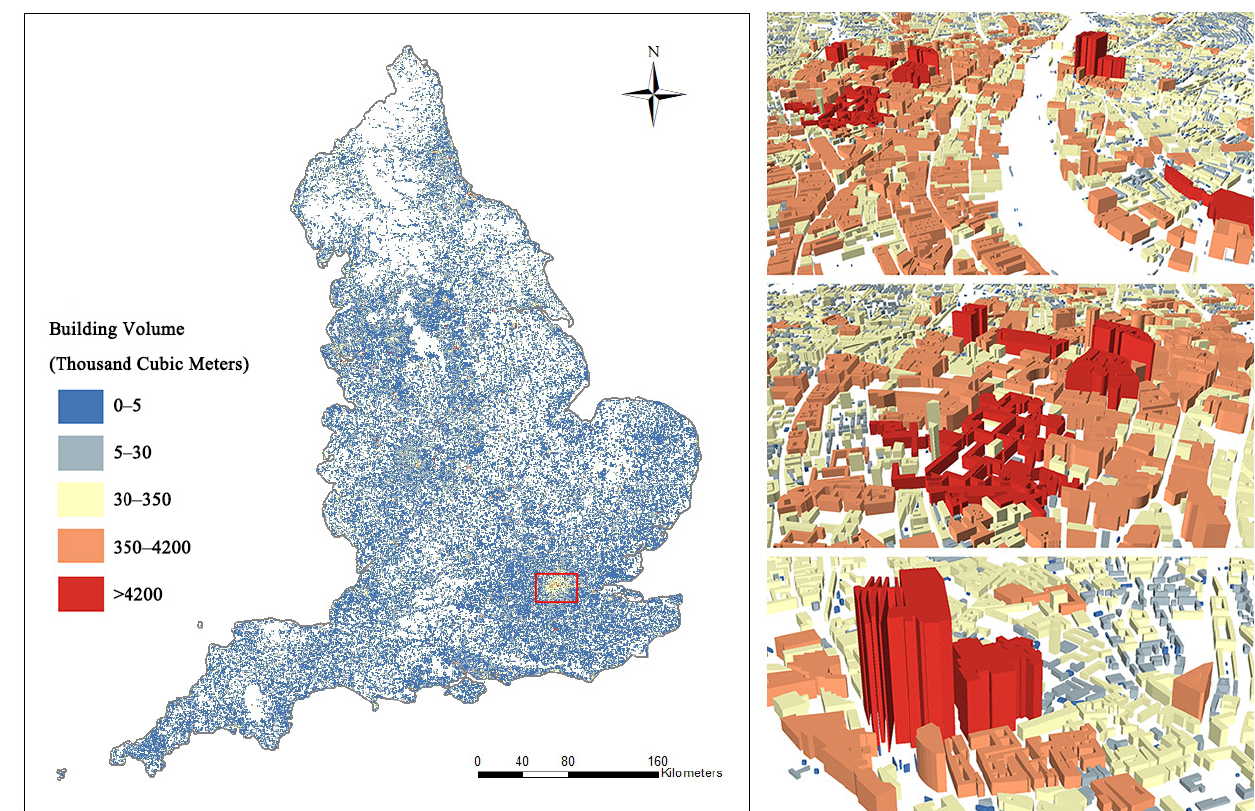
Figure 4. The spatial distribution of building volumes in England.